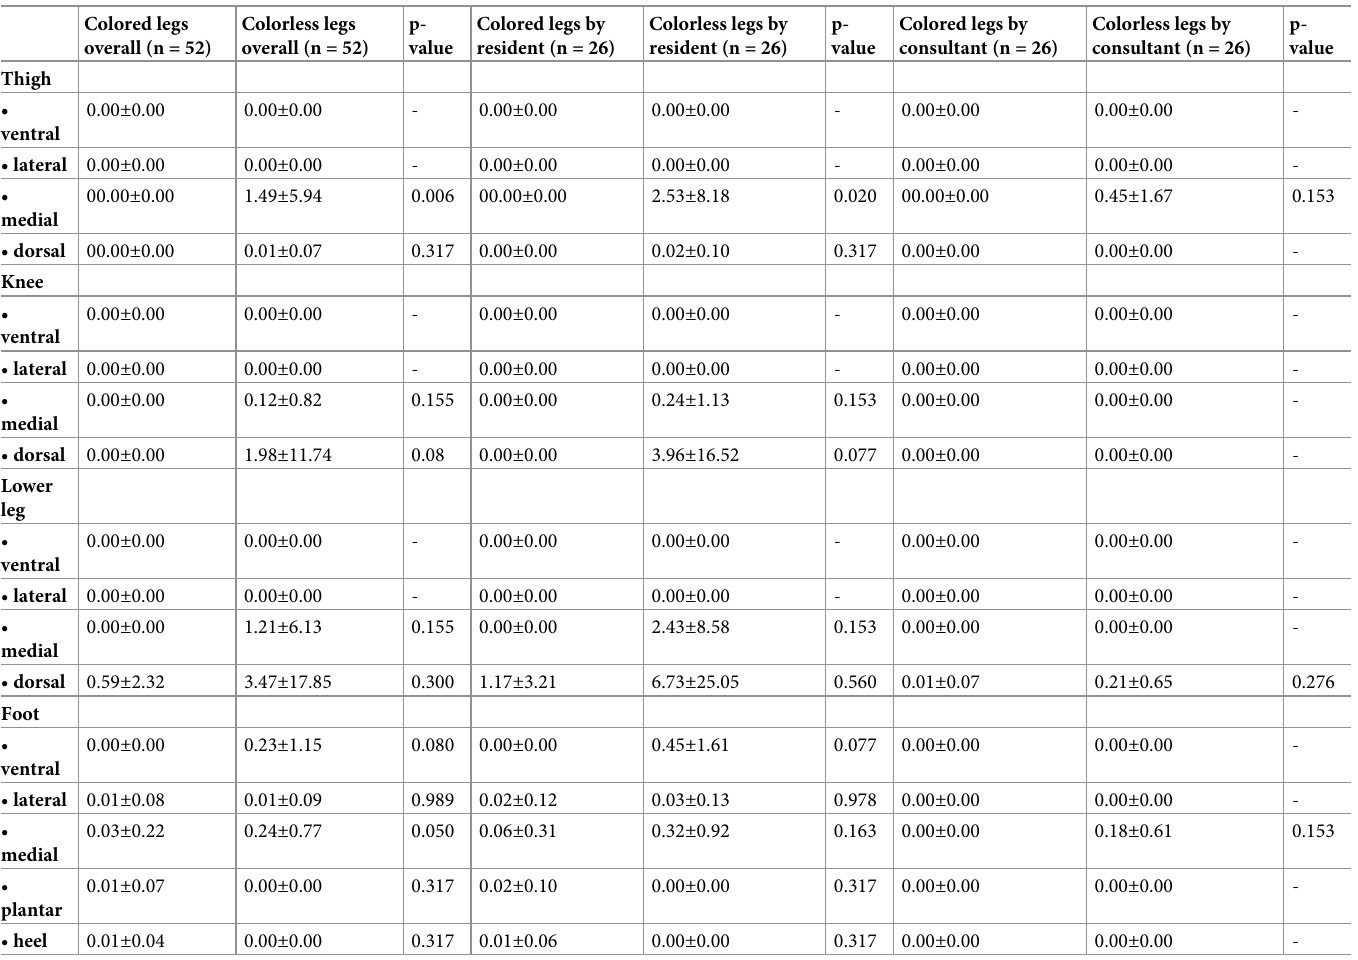
Table 1. Outcome